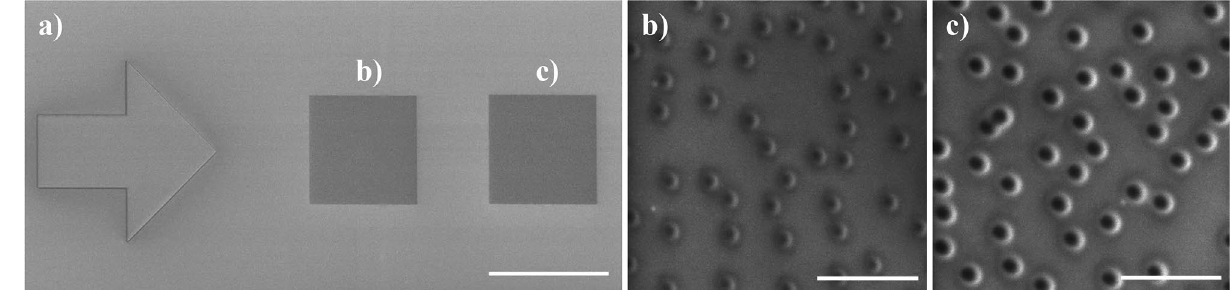
Figure 2. ( a ) Silicon mold with arrow-shaped marker and two 90 × 90 µm 2 arrays, each consisting of 37,825